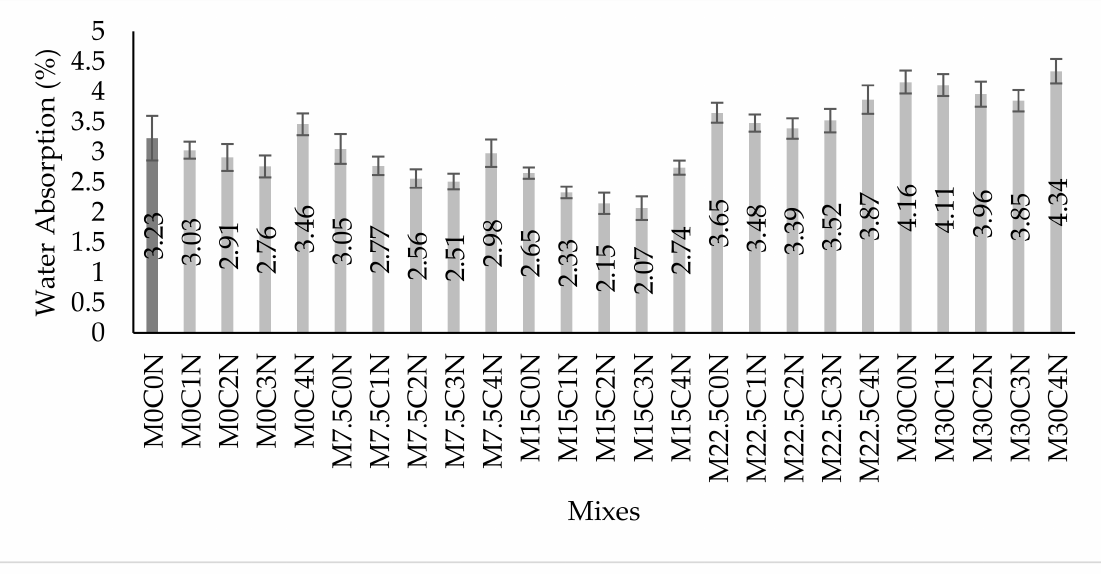
Figure 14. Water Absorption